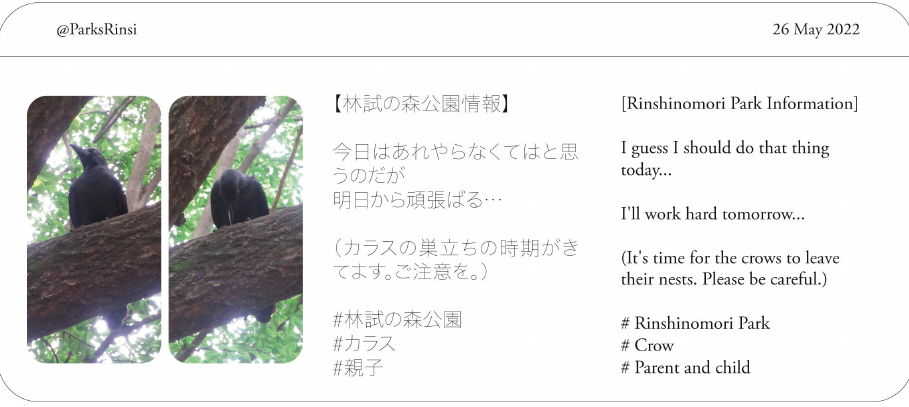
Figure 4. Tweet from the perspective of a crow. Original Japanese text and English translation.